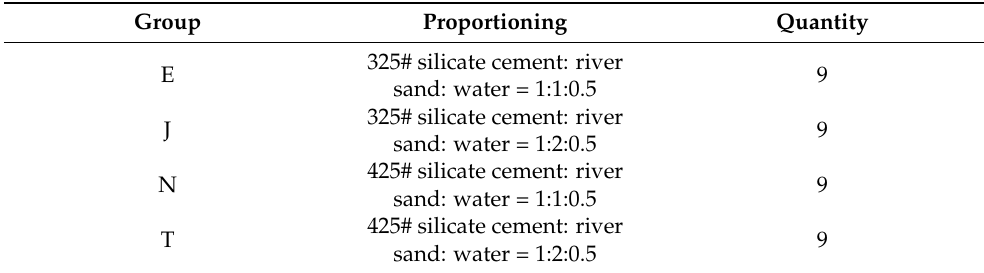
Figure 2. Cube test blocks. Table 2. Types of cubic test